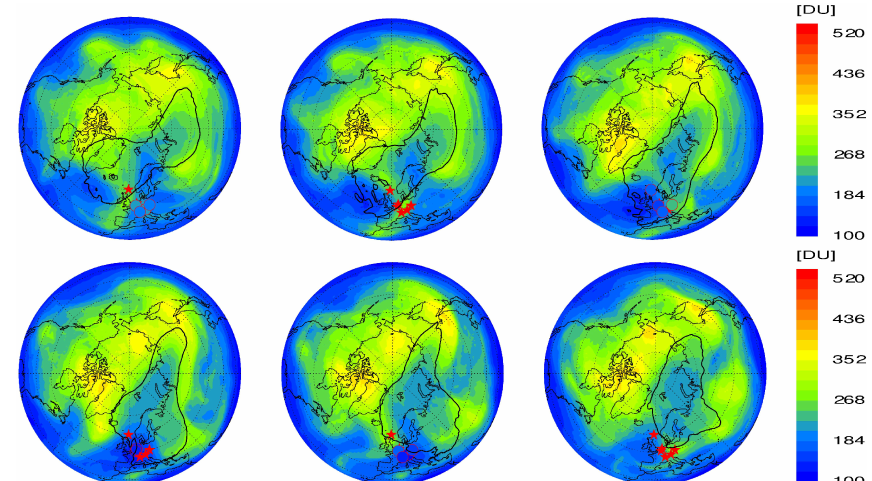
Fig. 7. Partial ozone column ( 2 = 350 to 700K) in DU for 16 to 18 (top row) and 19 to 21 (bottom row) January 2006, 12:00UT, simulated by CLaMS; boundary of the polar vortex is marked by the thick black line; sounding stations are marked either by red stars (no measurement) or by red circles (partial column measurement available, circles filled in respective colour code for Dobson Units).